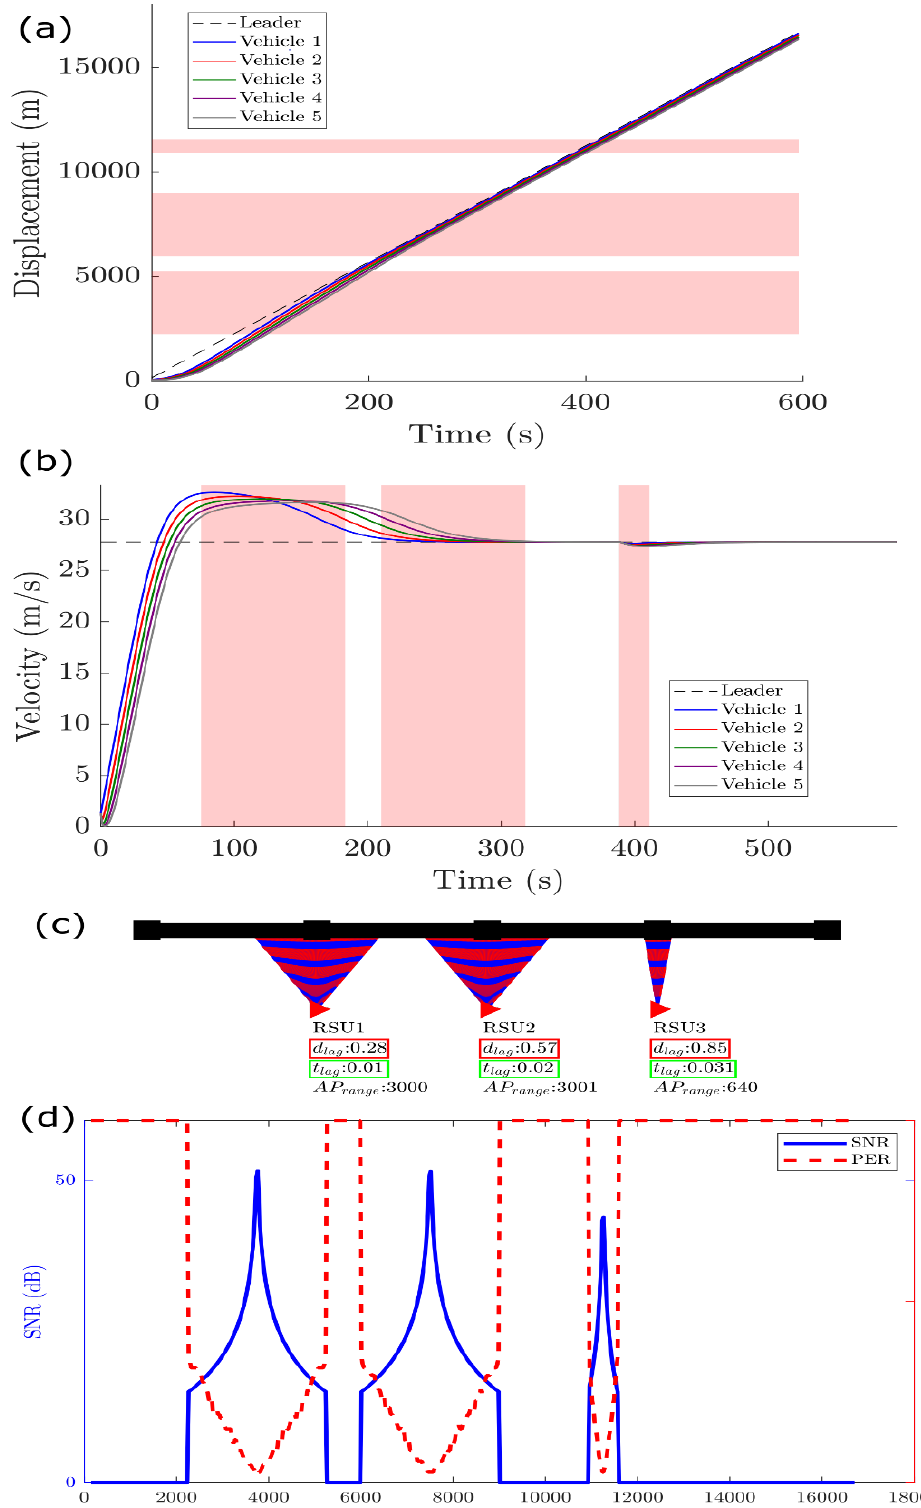
Figure 10. Case IV vehicle platoon motion for case IV, as described in Section 3.4: ( a ) Displacement of the vehicles over the simulation time; ( b ) Velocity of the vehicles over the simulation time; ( c ) Depiction of the coverage range of RSU’s (red) and the range during which the car communicates with the RSU (blue). The distance lag (red), time lag (green), and the RSU range are also mentioned; ( d ) Variation of SNR and PER as the platoon moves along the road. Leader is the platoon leader.